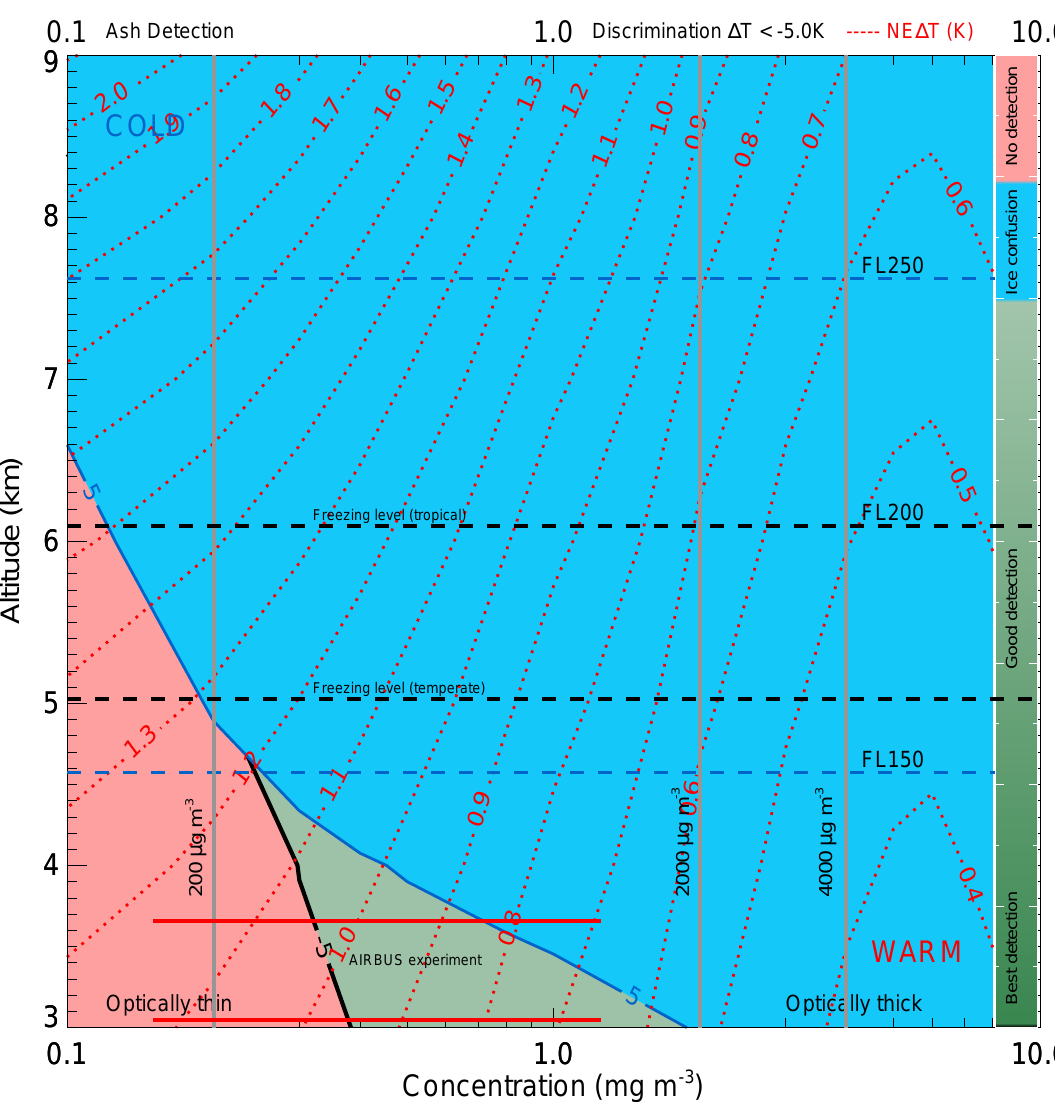
Figure 11. Discrimination against ice. r =3 µ m; ∆ T=-5 K. The plot shows ash concentration vs. altitude for the filters used on the AIRBUS experiment (10.9 µ m and 12.1 µ m). The red-coloured region shows where no detection is possible. The blue-coloured regions are parts of the atmosphere where the system is unable to discriminate ash from water, i.e. these substances appear the same. Green-coloured regions are where ash detection is possible. The red-coloured dashed contour lines indicate the calculated noise temperatures for the algorithm. A discrimination level of ∆ T=-5 K has been used (indicated by the black-coloured contour line). Less stringent levels ( ∆ T = -3 K) improve the detection range to lower concentrations but do not alter lack of detection with altitude; while more stringent levels compress the region of good detection. The solid red lines show the region of the atmosphere/ash concentration space sampled during the AIRBUS experiment. Three flight levels (FL) are shown and the locations of the freezing level is shown for a tropical and temperate atmosphere.